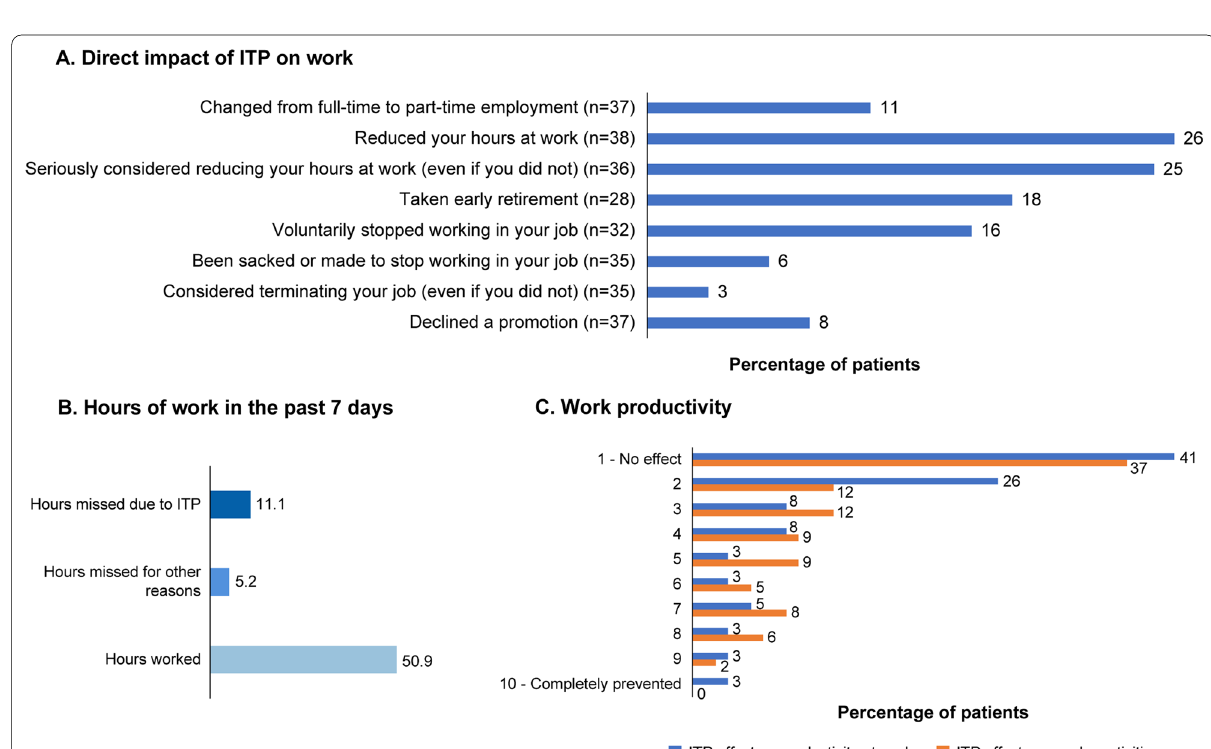
Fig. 4 Impact of ITP on